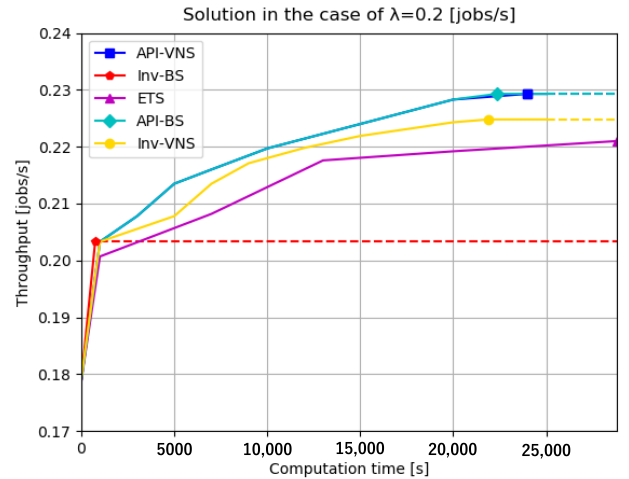
Figure 17. Computation time vs. throughput curves for the five methods in the case of λ = 0.2 in experiment 2.